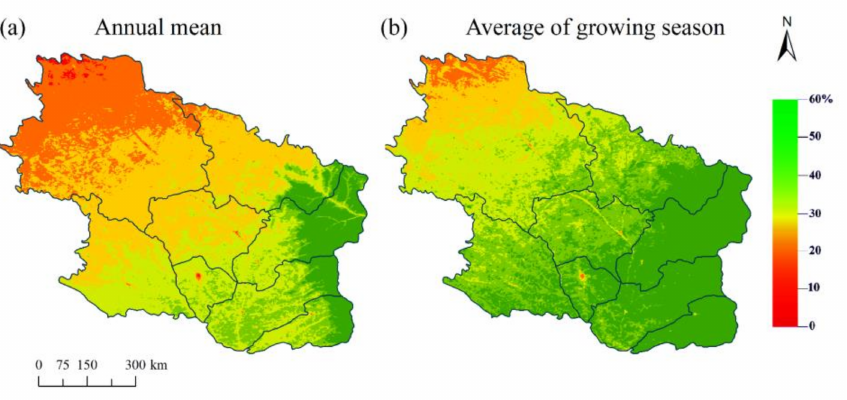
Figure 5. Spatial distribution of historical FVC average value for ( a ) annual ( b ) growing season from 2000 to